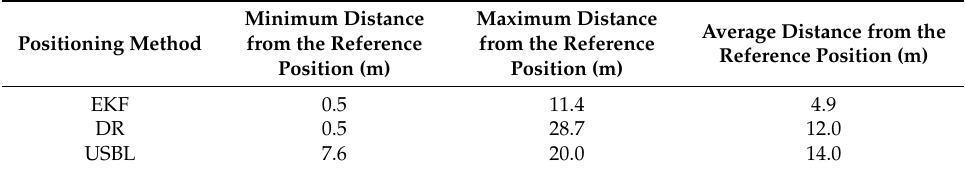
Table 10. Statistical parameters of positioning errors using EKF, DR methods and the USBL system (single passage).